Question: Generate an informative caption for the figure above.
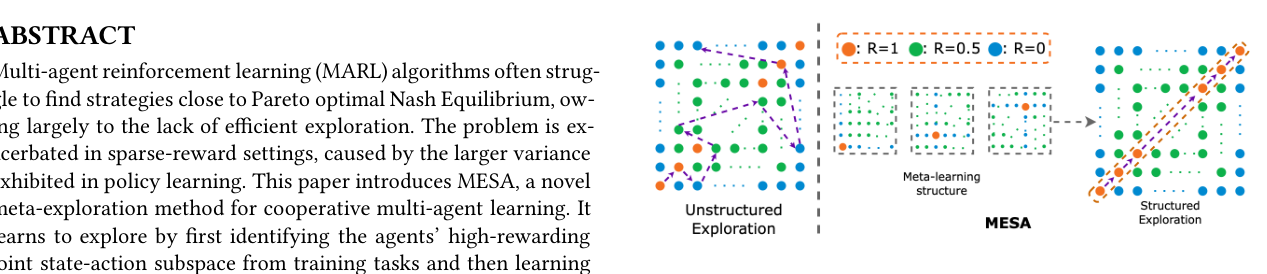
Answer: Illustration of structured exploration and unstruc- tured exploration behavior in the 2-player climb game. The rows and columns indicate the players’ action space. While unstructured exploration aims to visit novel states, structured exploration exploits structures in the joint state- action space, helping agents coordinatedly and more eﬃ- ciently explore the potential high-reward subspace.